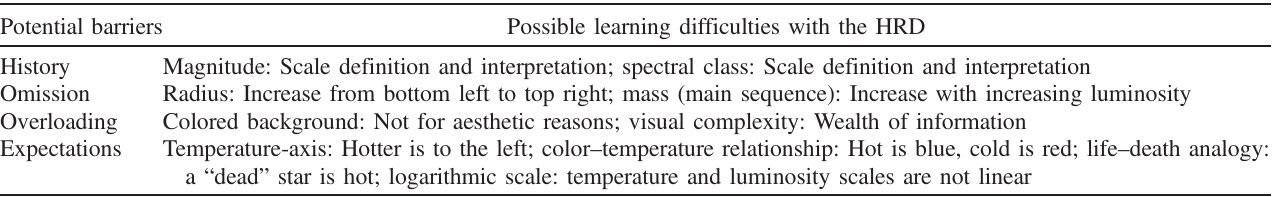
TABLE I. Potential learning difficulties expected for students extracting information from the HRD (Fig. 1) based on Airey and Eriksson